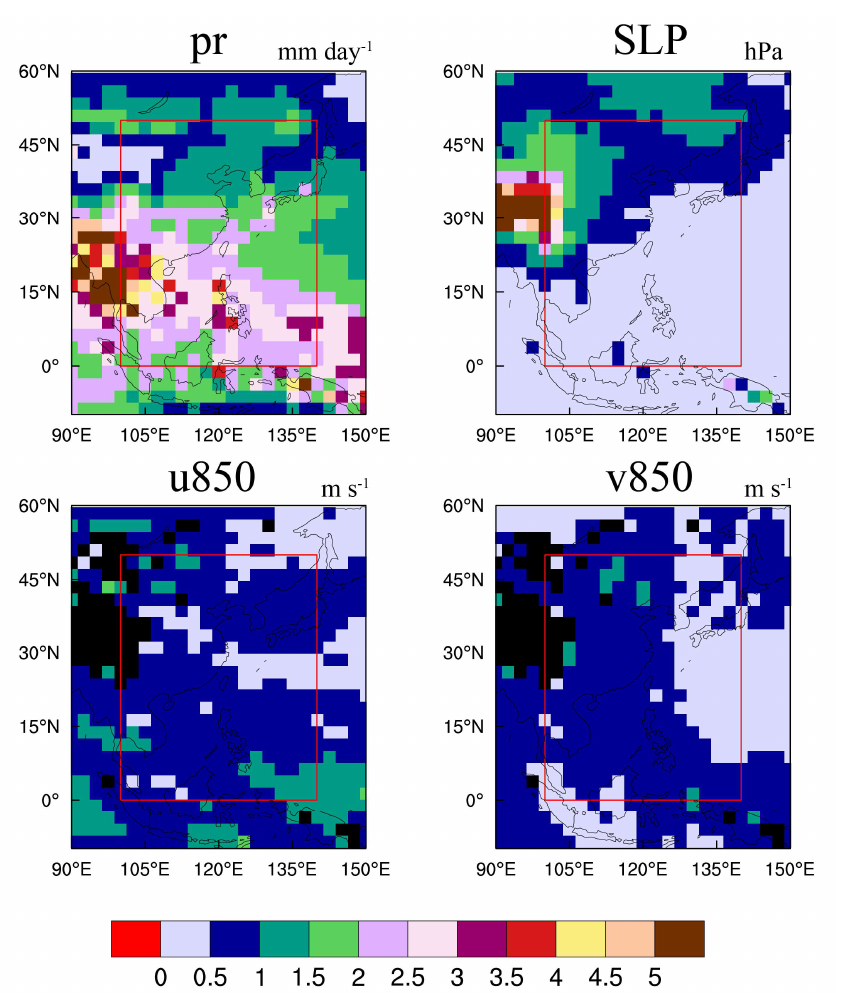
Figure 3. Spatial distribution of the multi-reanalysis ensemble deviation for June–July–August mean precipitation (pr), mean sea level pressure (SLP), and winds at 850 hPa (u850 and v850) from 1979 to 2010. The red box represents the East Asian summer monsoon region (0–50° N, 100–140° E). In the summer season, the land (ocean) is a heat source (sink), with lower (higher) mean sea surface pressure (Figure 5; cf. observation). The Tibetan Plateau presents a prominent low pressure centre due to its huge topography. The first-generation re-analysis datasets produce higher SLP in the Tibetan Plateau, the western part of the Indo-China peninsula and Indonesia, and lower SLP in Japan and the Sea of Japan (Figure 5; cf. NCEPI and NCEPII). The CFSR and the ERA-Interim have the same performance in presenting SLP in the Tibetan Plateau and Japan, but illustrate no significant BIAS in the Indo-China peninsula and Indonesia. However, these two datasets generate less SLP in the East China Sea. Both the JRA-55 and the MERRA show the prominent negative BIAS of SLP in the western (e.g., Tibetan Plateau, southwest of China etc.) and the northern (e.g., Mongolia, northern of China etc.) EASM region. The 20CR demonstrates positive BIAS at the centre of SLP in the south of the Tibetan Plateau, the northeast of China and the northern Sea of Japan, but produces less SLP in the western South China Sea and the Philippine Sea. Compared to the HadSLP2r, the ERA-20C generates more SLP in the Tibetan Plateau and the western Indo-China peninsula, but less SLP in the northern EASM